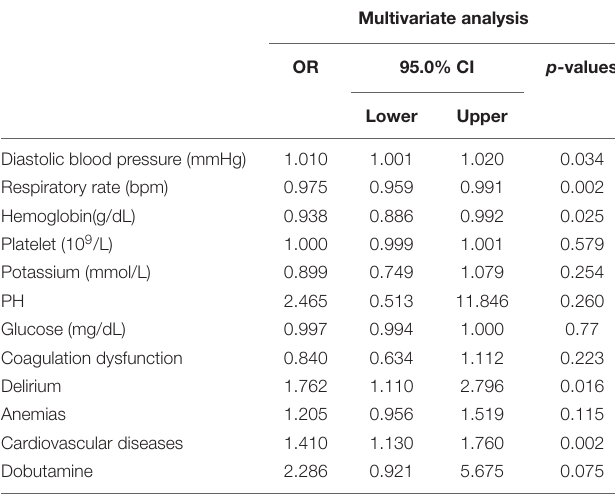
TABLE 2 | Multivariate logistic regression analysis of risk predictors to sleep